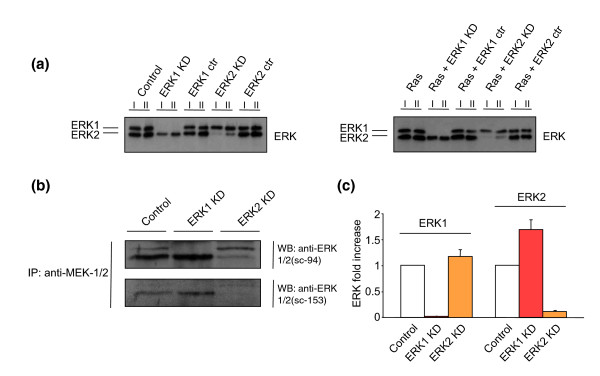
ERK-specific gene silencing in NIH 3T3 cells differentially affects MEK-ERK interactions. (a) ERK1- and ERK2-specific NIH 3T3 clones with stable shRNA expression only (left) or also co-transfected with H-RasQ61L (right) were isolated and checked for ERK expression levels by western blot analysis, as in Figure 1. Two clones (I and II) for each transfection are shown. (b) Lysates from wild-type NIH 3T3 control, ERK1 KD and ERK2 KD clones growing in 10% serum were incubated with anti-MEK-1/2 polyclonal antibody. Immune complexes (IP) were resolved in SDS-PAGE and western blotted (WB) with polyclonal anti-ERK1 (sc-94, top) and anti-ERK2 (sc-153, bottom) antibodies. (c) Bands from (b) were quantified and the relative fold increase in ERK1 and ERK2 levels in the knockdown samples over the corresponding wild-type controls were calculated (only samples probed with anti-ERK antibody sc-94 are indicated). Data are representative of three independent experiments, expressed as mean ± SEM.